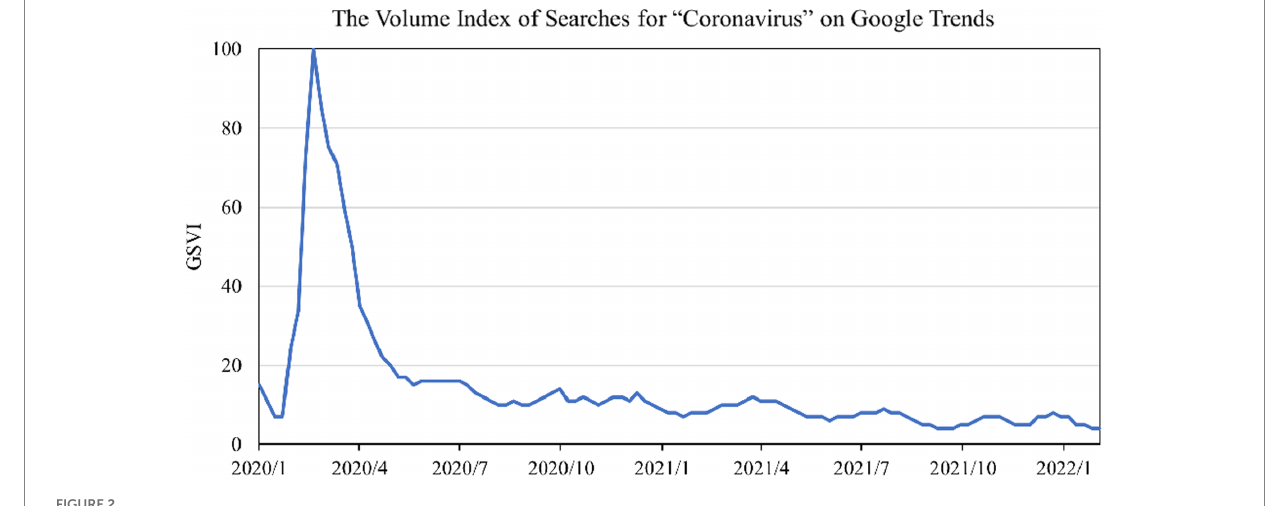
FIGURE 2 The volume index of searches for “coronavirus” on Google